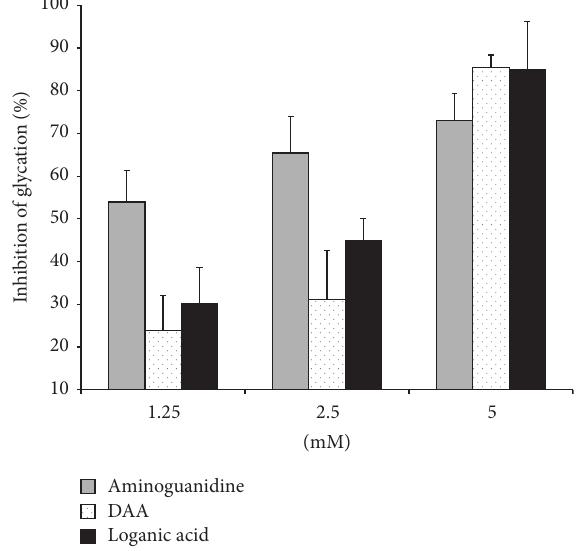
Figure 1: Mean antiglycation activity (with standard deviation) of two iridoids, deacetylasperulosidic acid (DAA) and loganic acid, and aminoguanidine (positive control) at 1.25mM, 2.5 mM, and 5 mM in the bovine serum albumin/fructose/glucose antiglycation assay. Inhibition of glycation (%) was determined by comparing fluorescence intensities (360 nm excitation, 460nm emission) of samples and positive control to those of reference